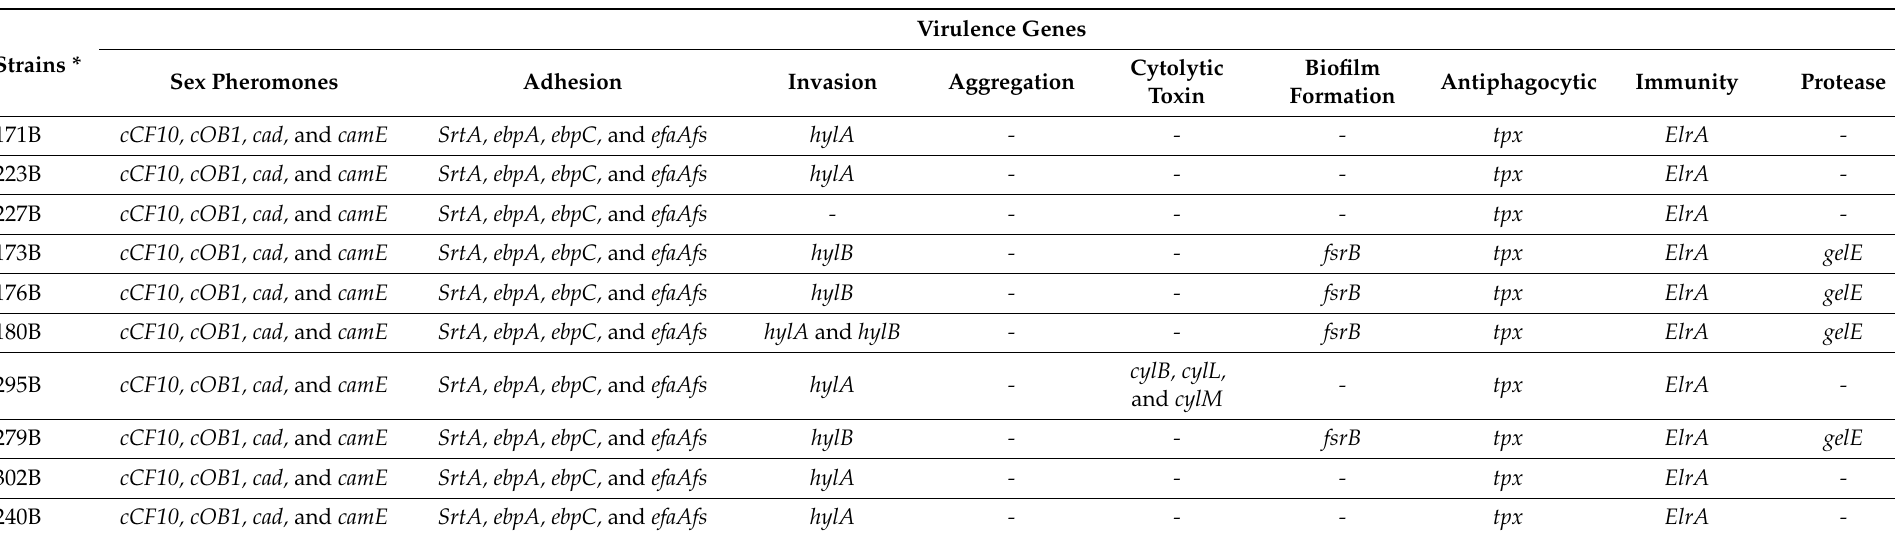
Table 3. Virulence gene profiles based on the whole-genome sequencing of the optrA -carrying linezolid-resistant Enterococcus faecalis strains from retail chicken